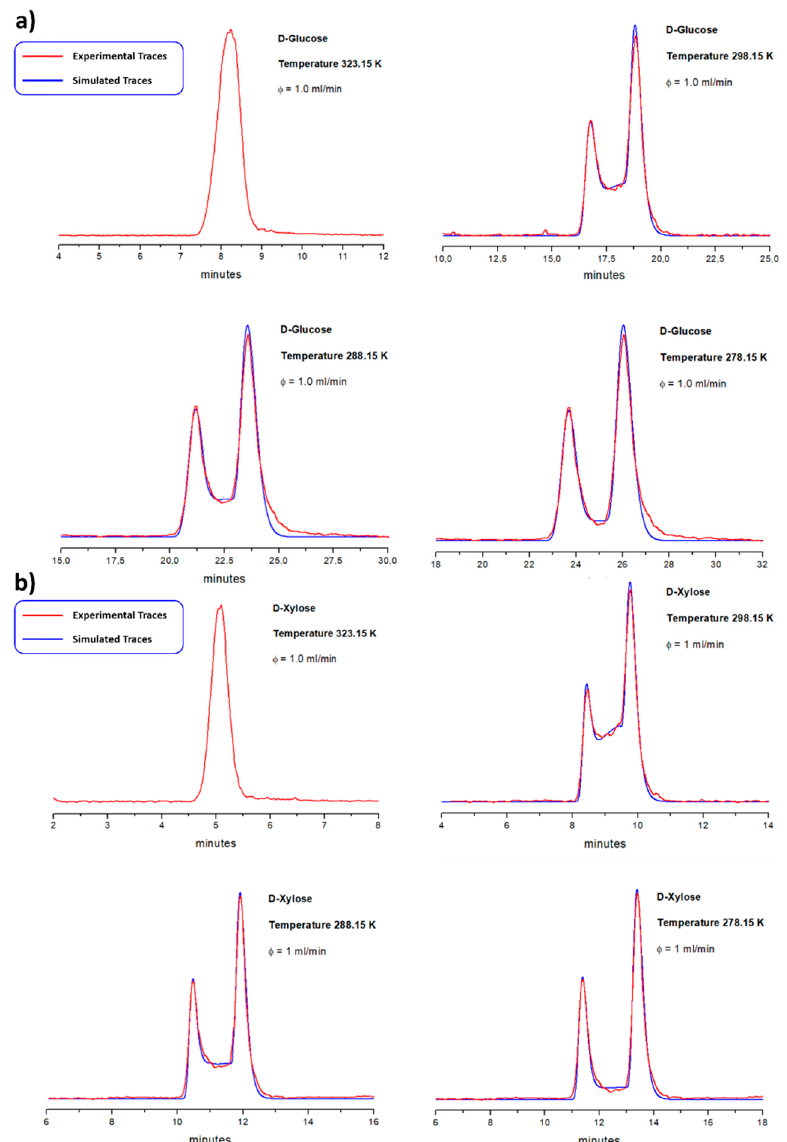
Figure 3. Experimental dynamic chromatograms of ( a ) D-glucose and ( b ) D-xylose registered at different temperatures (red traces) and their superimposed simulations (blue traces), performed with the Auto-DHPLC-Y2K software. Experimental conditions: cysteine stationary phase column (5 µm, 150 × 4.6 mm L × I.D.). mobile phase: acetonitrile/water 85/15 (% v / v ), flow rate: 1.0 mL/min; detector: ELSD (T Drift : 70 °C; P: 45 psi; Gain: 10).